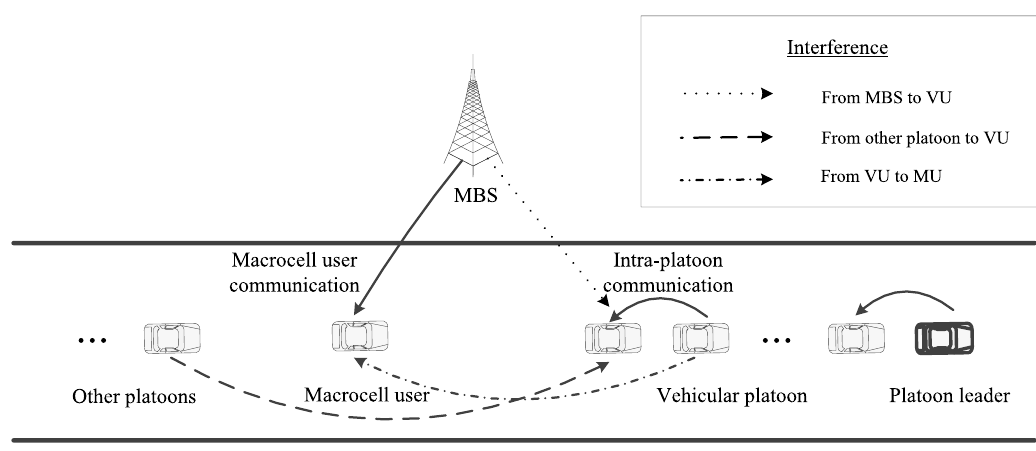
Figure 1. Scenario: The cellular vehicle-to-everything (C-V2X) network including platoons consists of vehicle users (VUs) and the underlying macrocell user